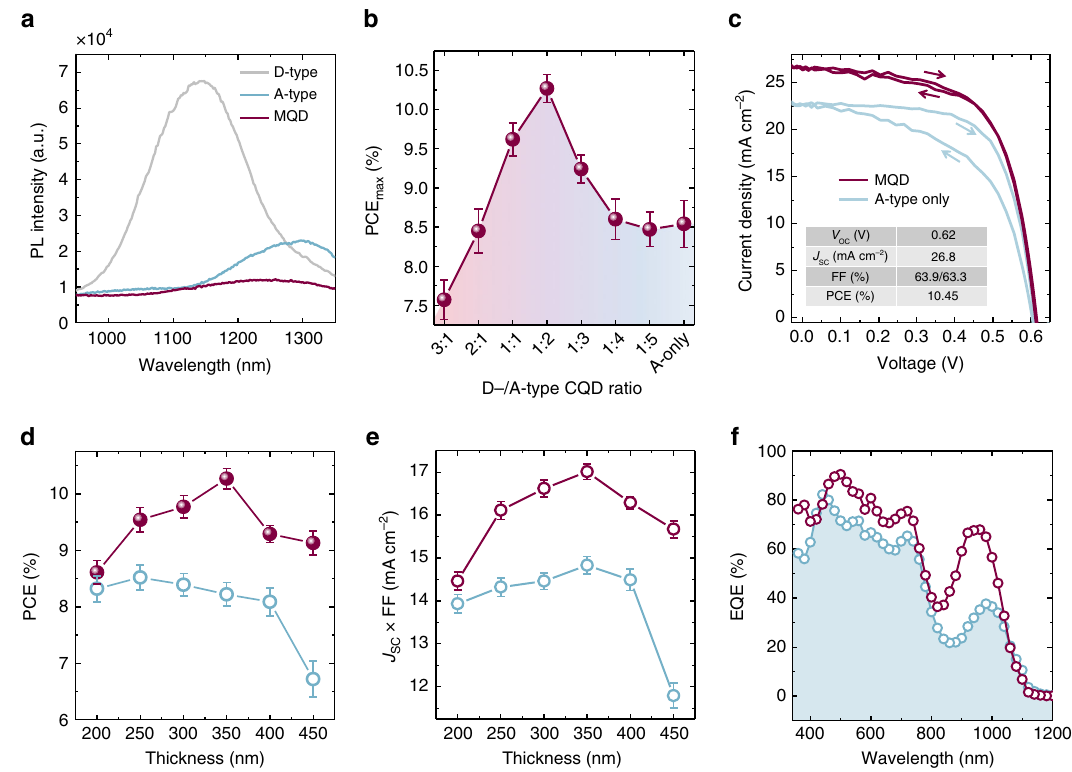
Fig. 5 Optoelectronic behaviors of mixed-quantum-dot solids and device performance. a Photoluminescence spectra of TG-, MAPbI 3 -capped, and mixed QD fi lms con fi rming the quenching effect on mixed QD sample because of ef fi cient charge separation between donor/acceptor QDs. b Power conversion ef fi ciency (PCE) values of mixed QD devices with different mass ratios of D- (TG-capped) and A-type (MAPbI 3 -capped) QDs. c Current − voltage ( J − V ) characteristics under simulated AM 1.5 illumination for BHJ device and control A-type only (MAPbI 3 -capped) PbS device. d Thickness-dependent PCE and e thickness dependent of BHJ and control perovskite-passivated QD devices. f EQE spectra of champion-mixed QD device and perovskite-passivated QD control sample. Error bars in b , d , and e represent the standard deviation of several